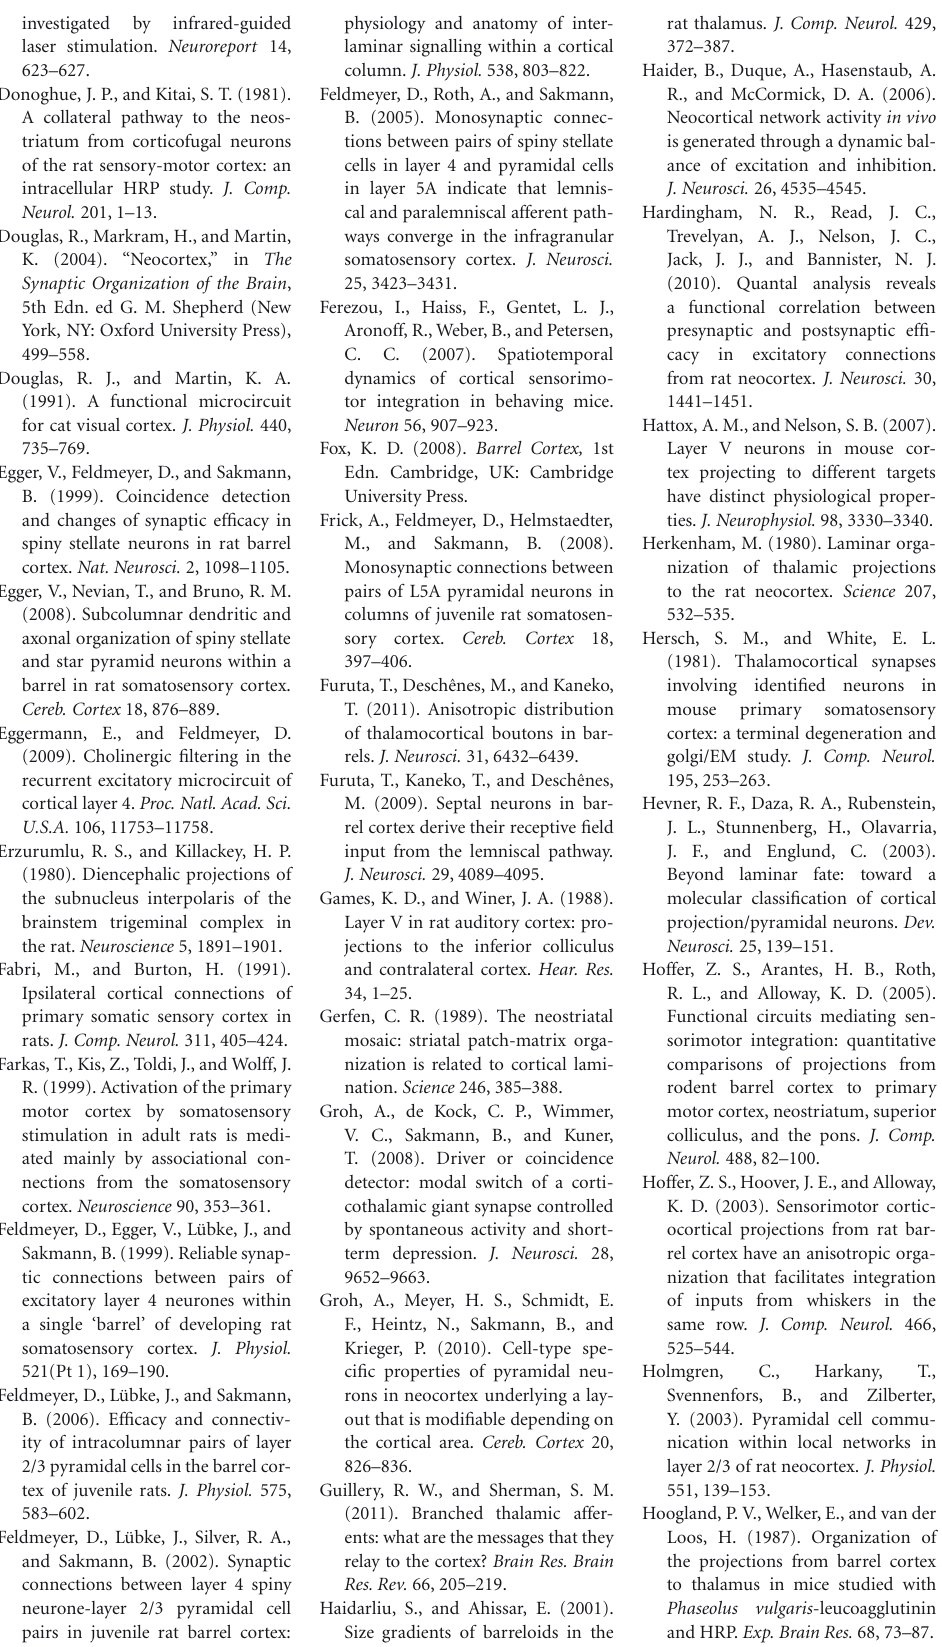
sensitive VPM neurons in the rat.